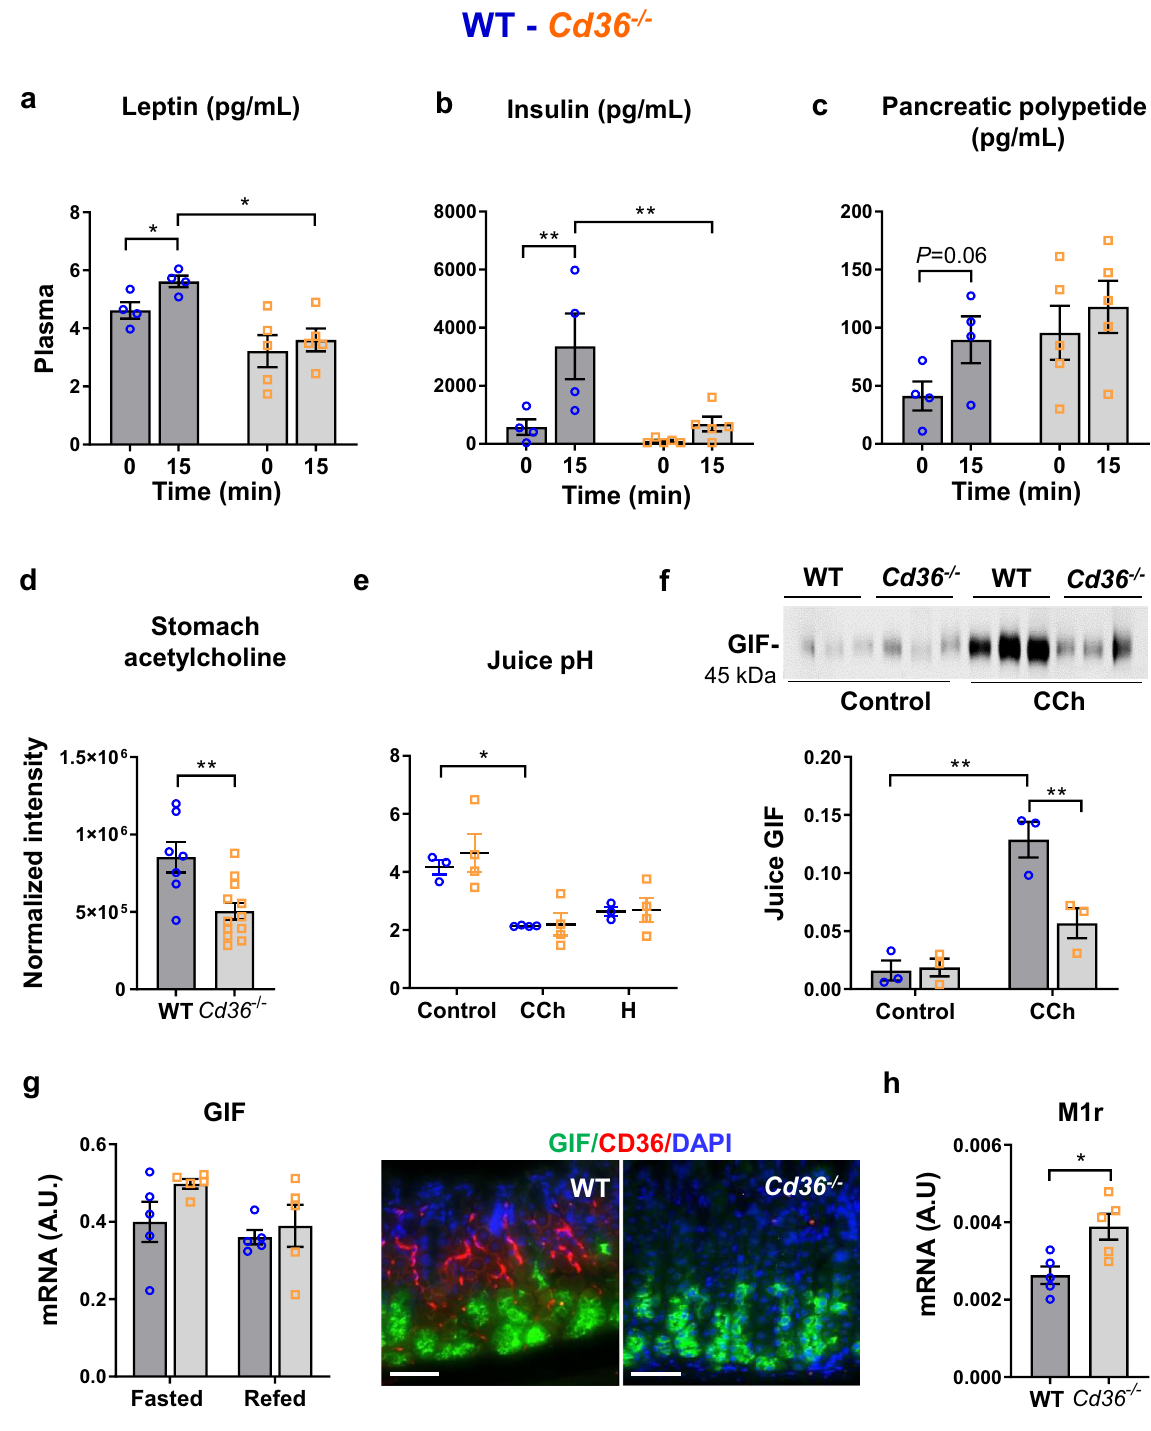
Fig. 2 Cephalic response to oral high fat and gastric secretions in germline Cd36 − / − mice. a – c Impaired response of plasma leptin, insulin, and pancreatic polypeptide in fasted mice and 15 min after an oral high fat meal. d Stomach acetylcholine levels in 4 h refed mice. e,f Gastric secretions at 1 h after pylorus ligation in 18 h fasted mice given i.p. saline (Control), carbachol (CCh, 60 µ g/kg) or histamine (H, 10 mg/kg). e Gastric juice pH. f Immunoblots of gastric juice; quanti fi cation of gastric intrinsic factor (GIF)/total protein in juice showing reduced GIF output in Cd36 − / − mice given carbachol. g Chief cells markers by qPCR and immunostaining (green) in corpus of wildtype (WT) and Cd36 − / − mice, scale: 50 µ m. h mRNA of muscarinic receptor 1 (M1r) in the corpus of WT and Cd36 − / − mice. Signi fi cance was calculated using a two-way ANOVA followed by post hoc tests by Sidak multiple comparisons or a two- sided unpaired t test ( d and h ). * P < 0.05, ** P < 0.01. a – c n = 4 – 5 per condition/group; d : n = 7 – 12; e,f n = 3 – 4; g,h n =